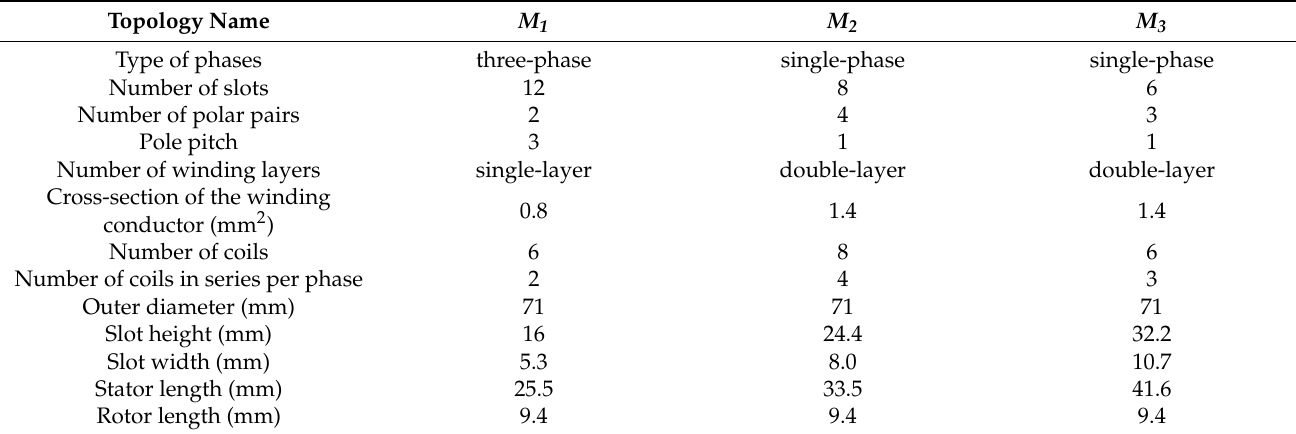
Table 3. Topologies M 1 , M 2 and M 3 features.